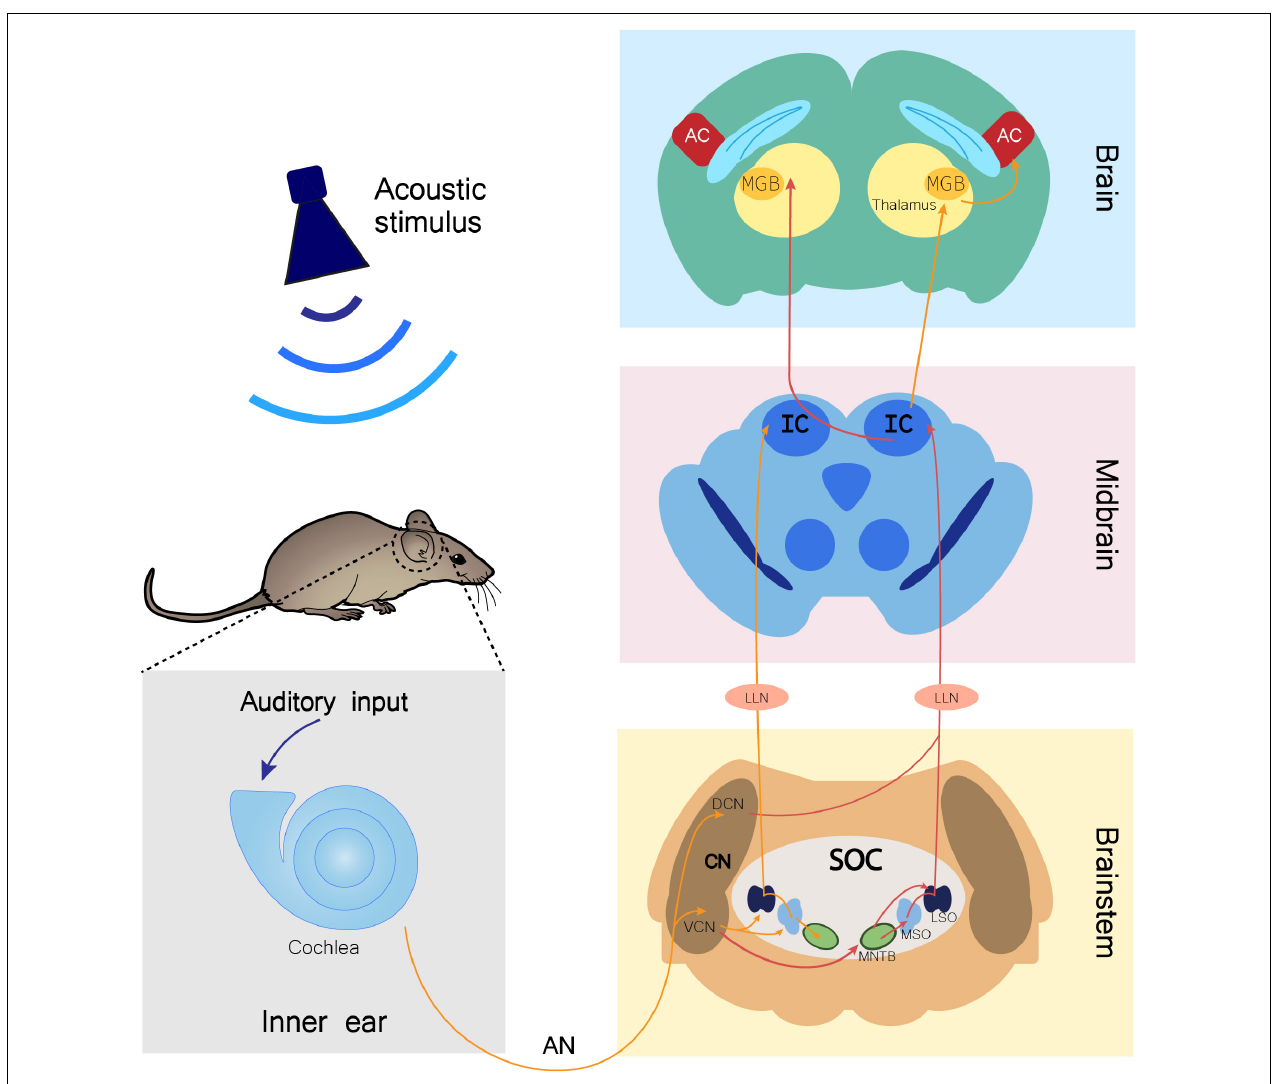
FIGURE 1 | Monoaural ascending auditory pathway. Auditory input arriving to the cochlea is transmitted through the auditory nerve (AN) to the cochlear nucleus (CN) in the brainstem. In this nucleus, AN bifurcates to the ventral cochlear nucleus (VCN) and the dorsal cochlear nucleus (DCN). Information is directed to the ipsilateral (orange arrows) and contralateral (red arrows) SOC (superior olivary complex), traveling through several of its nuclei, namely the lateral superior olive (LSO), medial superior olive (MSO), and medial nucleus of the trapezoid body (MNTB). Both contralateral and ipsilateral input from the brainstem reach the inferior colliculus (IC) in the midbrain through fibers of the lateral lemniscus (LL), synapsing in the LL nucleus (LLN). From the IC, fibers project ipsilaterally and contralaterally to the medial geniculate body (MGB). The MGB is located in the thalamus and is the brain region that precedes the auditory cortex (AC) in the information flow of ascending auditory pathway (Knipper et al., 2013; Di Bonito and Studer,